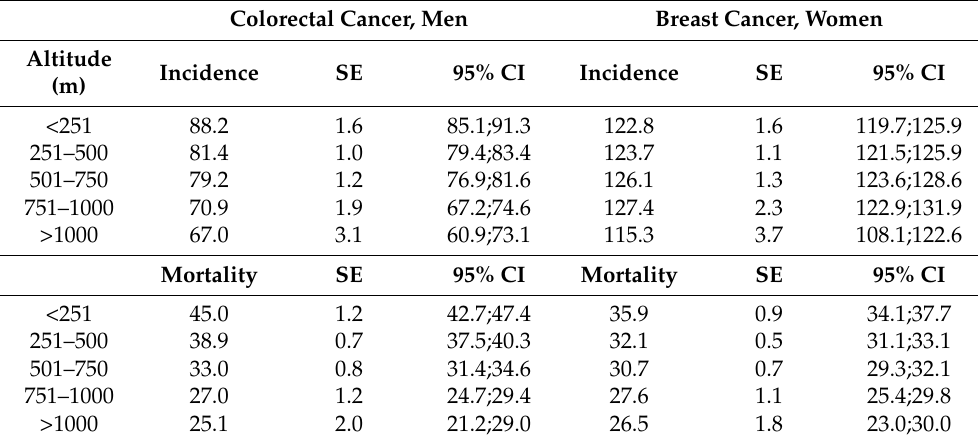
Table 1. Age-standardized incidence and mortality rates for colorectal cancer in Austrian men and breast cancer in Austrian women in dependence of the altitude of residence. Colorectal Cancer, Men Breast Cancer, Women